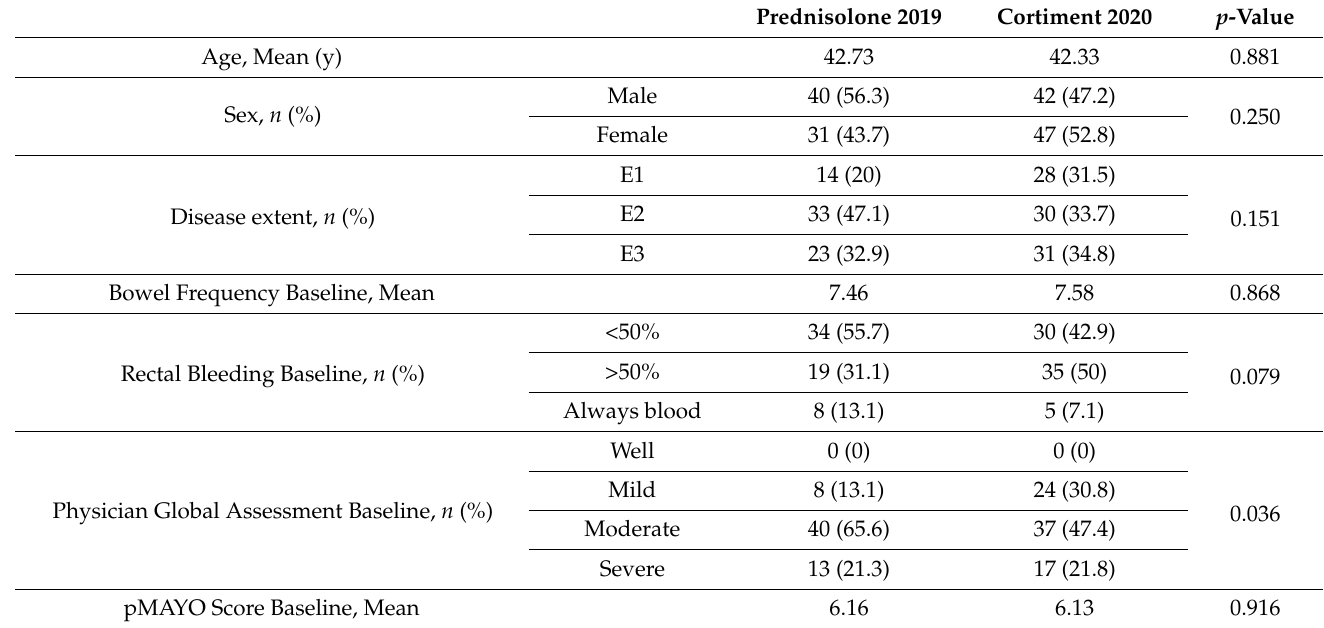
Table 3. Comparison of Prednisolone results in 2019 versus Cortiment results in